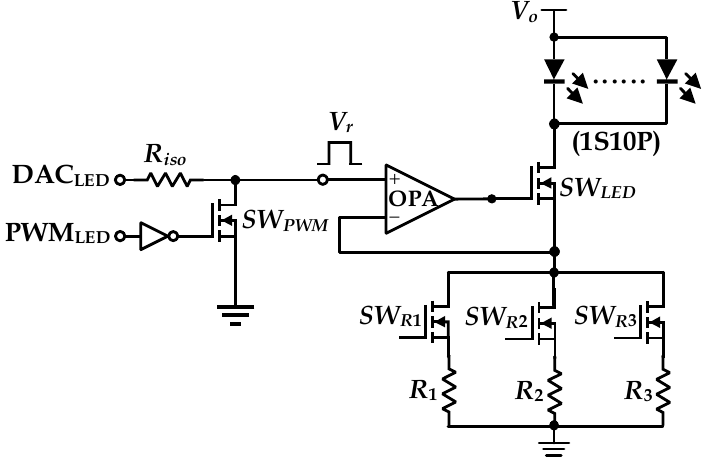
Figure 7. Scheme of the dimming with the VCSR method.